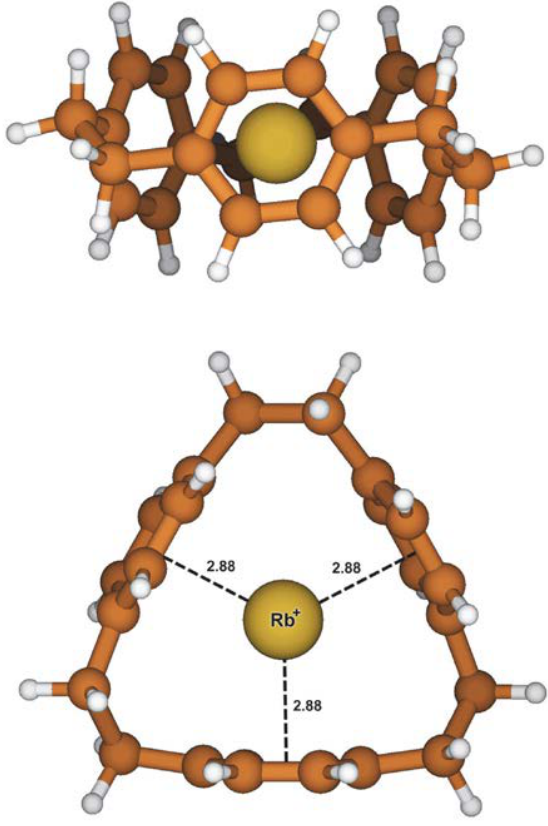
Figure 5 . Two projections of the DFT optimized structure of the [Rb(C 24 H 24 )] + complex (ω-B97XD / def2-TZVP); the distances be- tween the “central” cation Rb + and the centroids of the three ben- zene rings are 2.88, 2.88, and 2.88 Å.